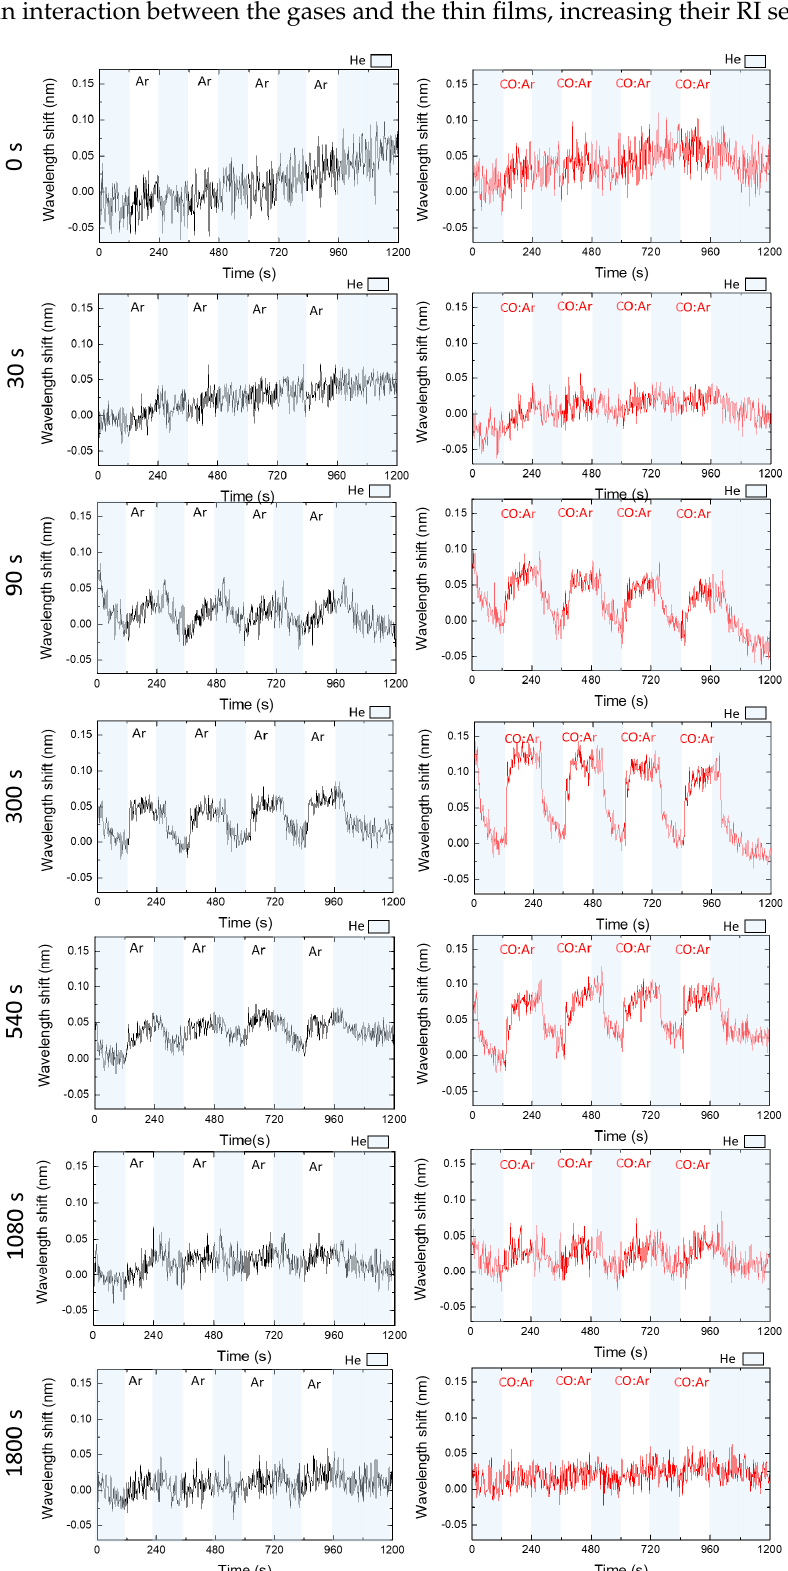
Figure 6. Wavelength shifts of the LSPR peak position of the Au:CuO film over time for 5 cycles of He (shaded areas) and pure Ar (black) and 50 ppm of CO in Ar (red) after different Ar plasma treatments times.